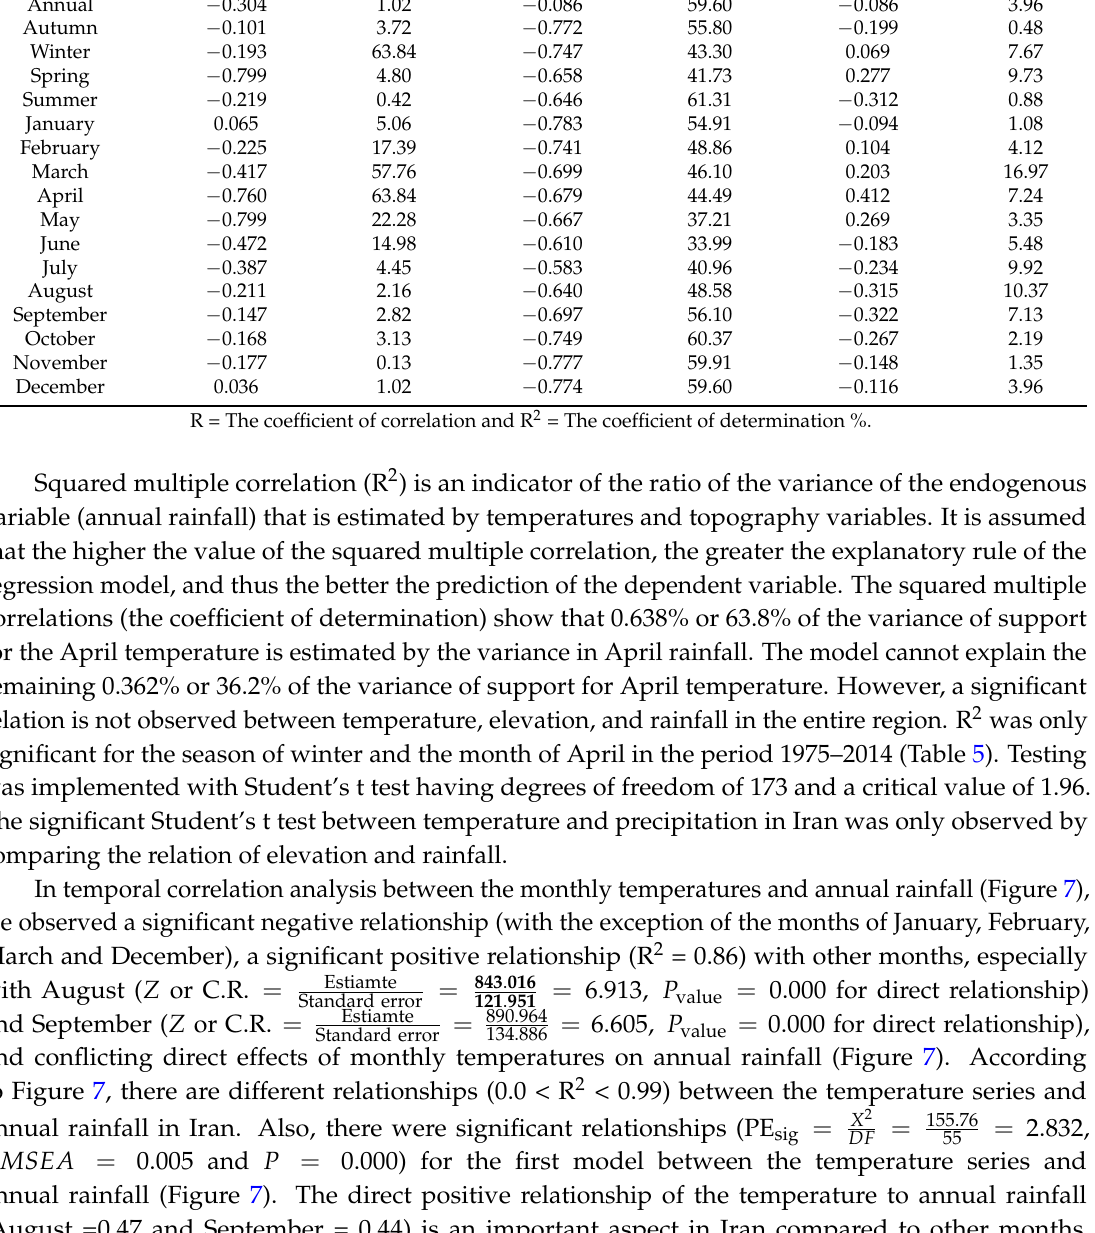
Table 4. The results of the correlation analysis between temperature, elevation and rainfall. R Temperature Period and Rain − 0.304